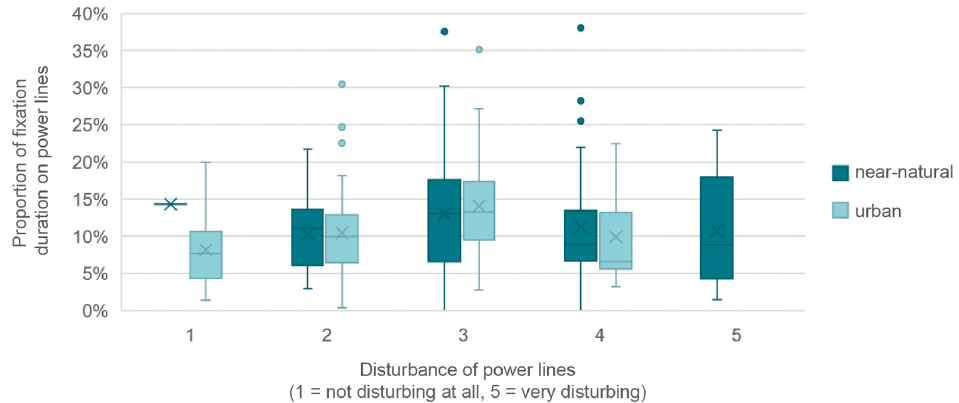
Figure 8. Proportion of the fixation duration on power lines during guided perception correlated with the rating of the disturbance of power lines for near-natural and urban landscape types.